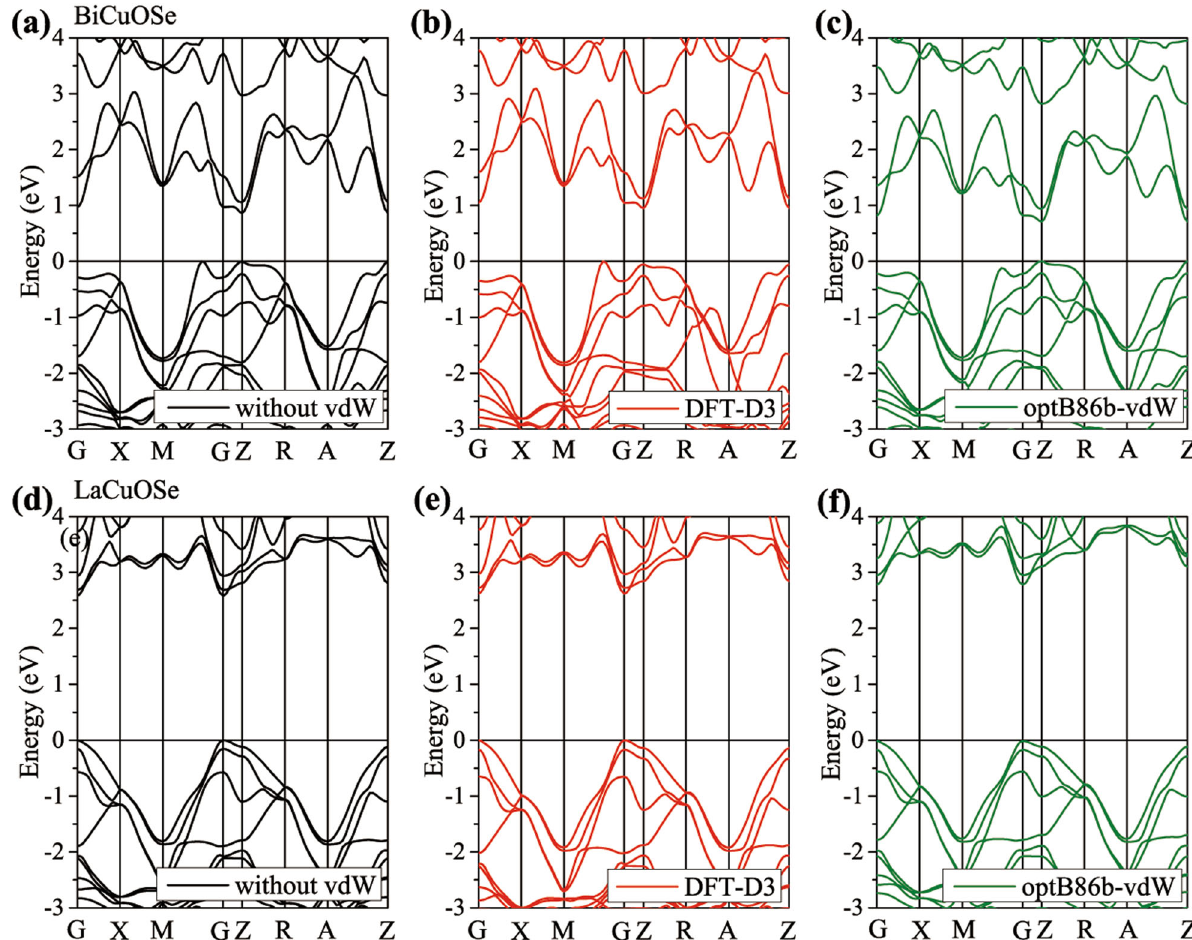
Fig. 8 Effects of vdW correction on electronic structure. The calculated band structures for BiCuOSe ( a – c ) and LaCuOSe ( d – f ) with and without vdW